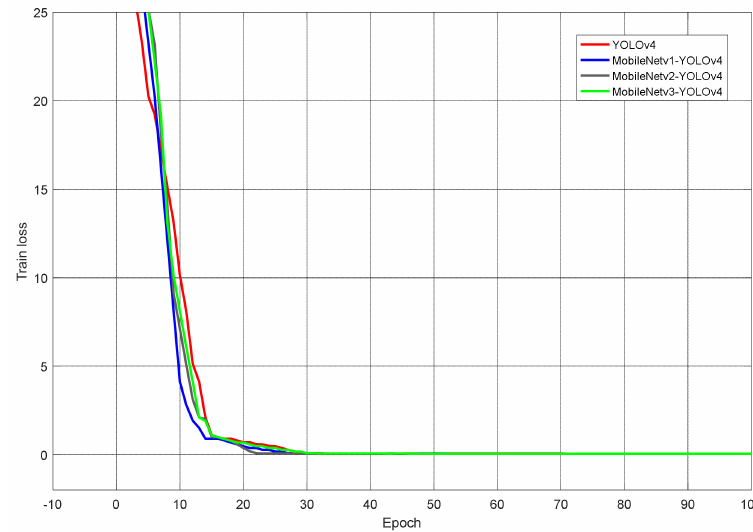
Figure 10. The loss values of YOLOv4 and the improved